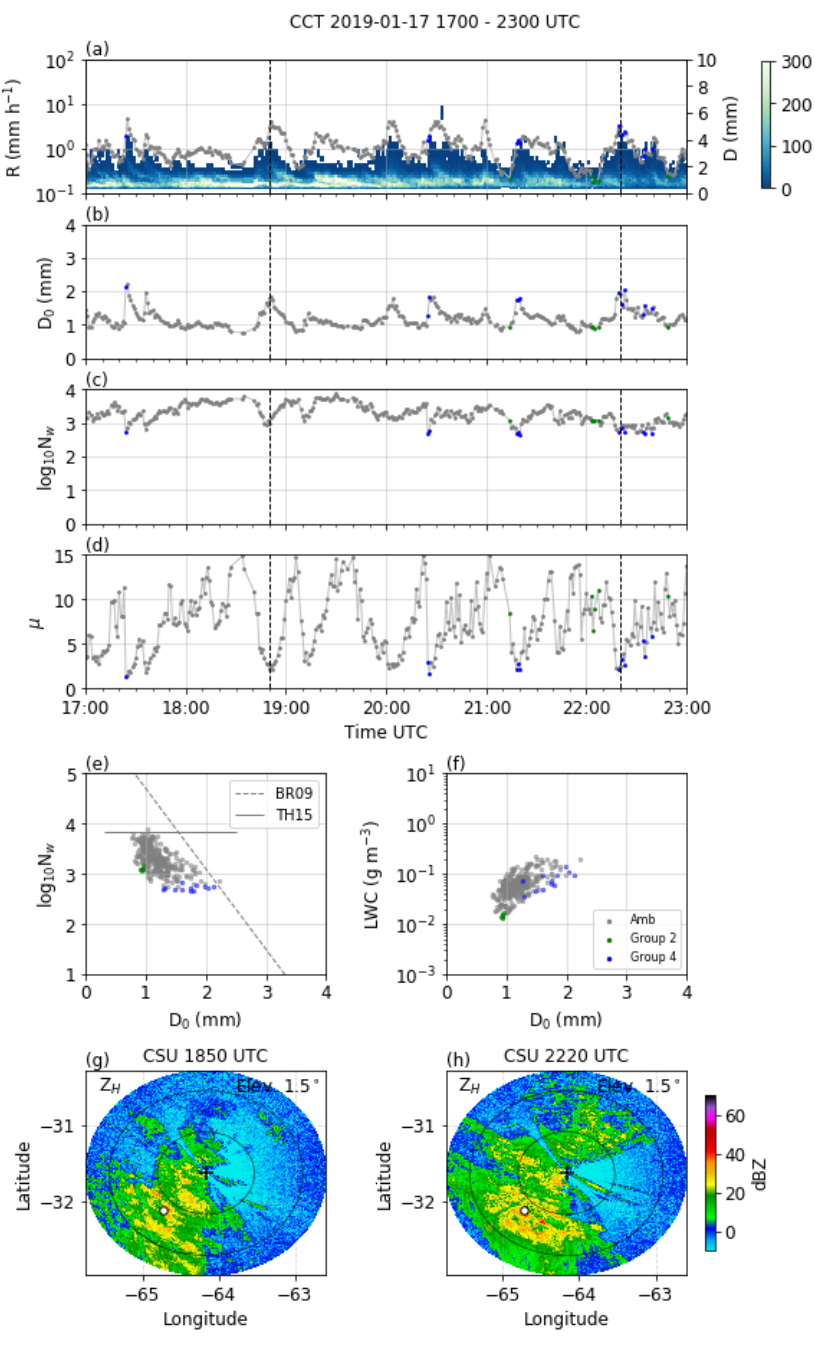
Figure 9. Temporal evolution of ( a ) R (dots) and N ( D ) (color shading), ( b ) D 0 , ( c ) log N w , and ( d ) µ as measured by disdrometer CCT on 17 January 2019 from 1700 to 2300 UTC. Projection of each 1 min DSD in the ( e ) log N w - D 0 and ( f ) LWC- D 0 parameter spaces. PPI of Z H measured by the CSU radar at ( g ) 1850 UTC and ( h ) 2220 UTC. The marker color in ( a – f ) indicates the group according to the D18 classification. Dashed lines in ( a – d ) mark the times of the radar images. The rings in ( g , h ) indicate the 60 and 120 km ranges. The white marker shows the position of the